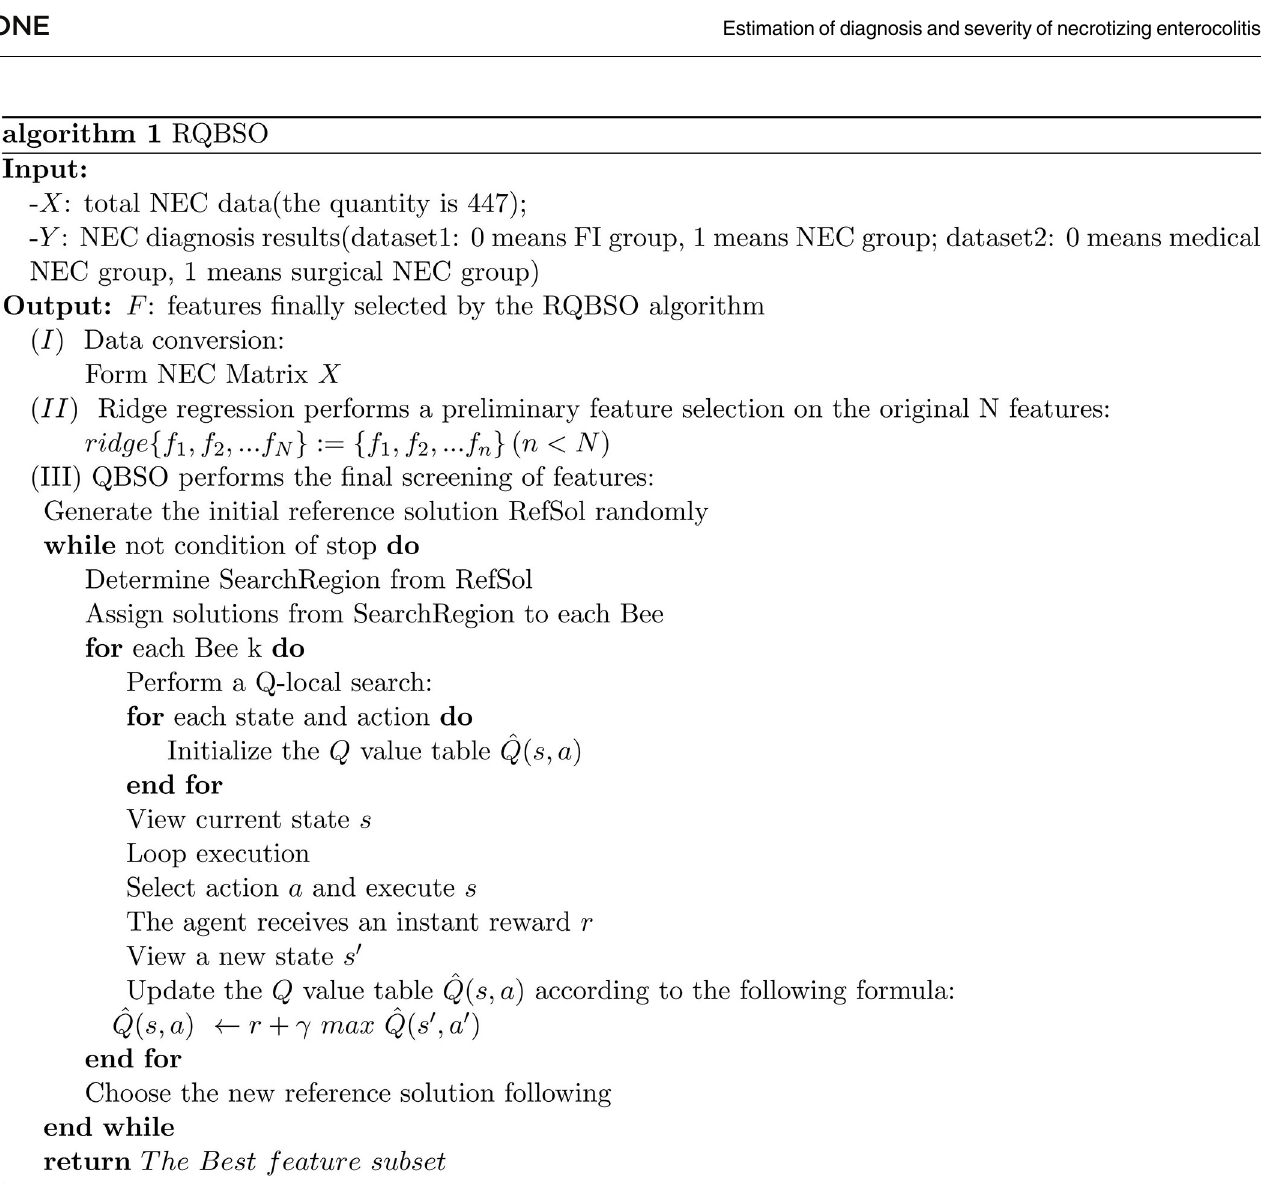
Fig 3. The pseudocode of the used RQBSO